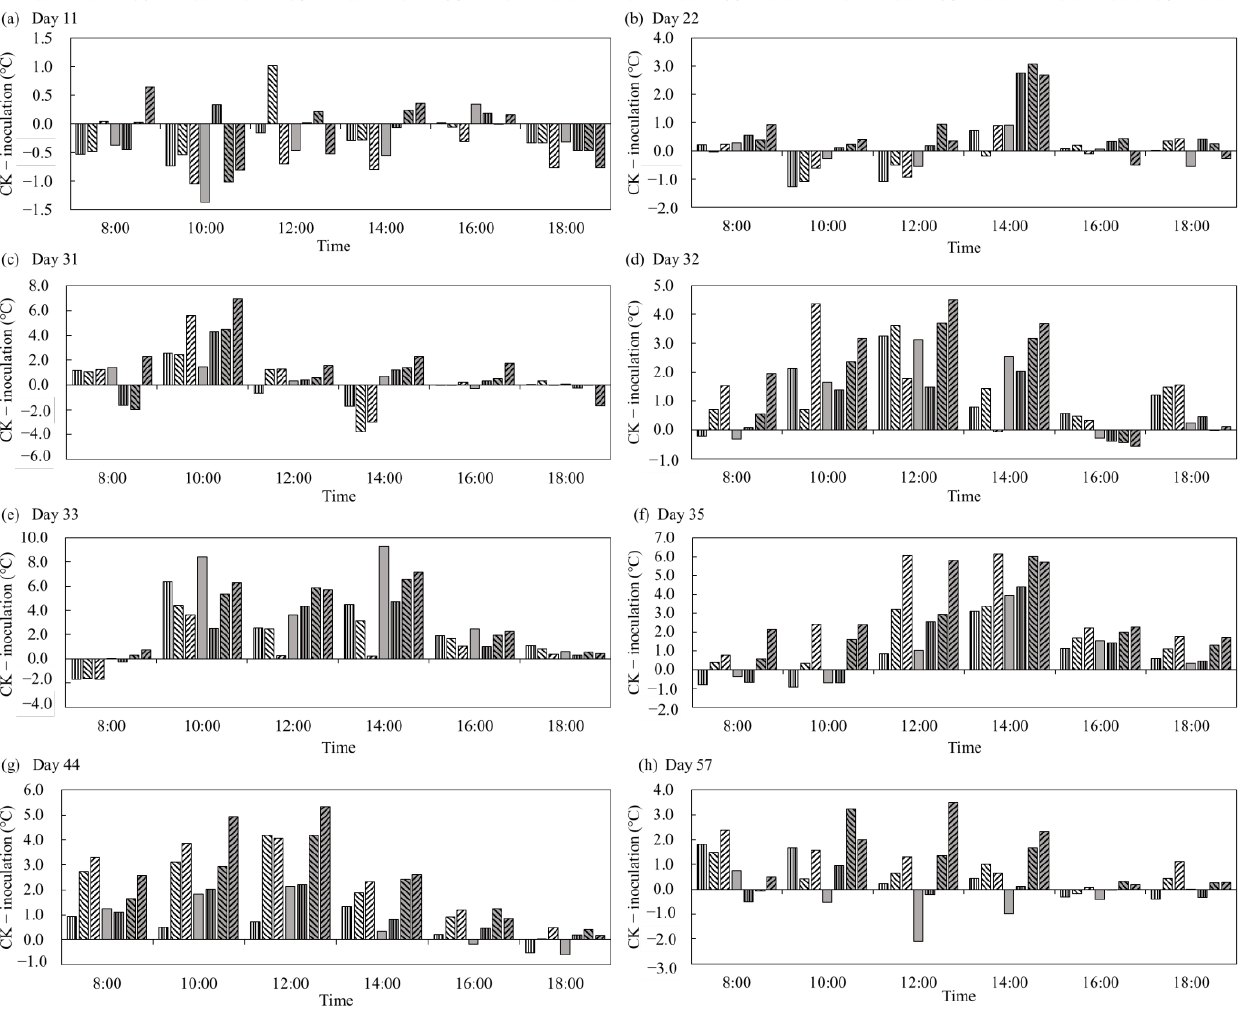
Figure 3. Differences in plant canopy temperature between controls and inoculation treatments on the ( a ) 11th, ( b ) 22nd, ( c ) 31st, ( d ) 32nd, ( e ) 33rd, ( f ) 35th, ( g ) 44th and ( h ) 57th days. CK—inoculation represents the difference between the mean of CK and inoculation. Control (CK), treatments with sterilized DSE and AMF; DSE20%, 2 × 10 5 CFU mL −1 of DSE with sterilized AMF; DSE40%, 4 × 10 5 CFU mL −1 of DSE with sterilized AMF; DSE80%, 8 × 10 5 CFU mL −1 of DSE with sterilized AMF; AMF, sterilized DSE with AMF; DSE20% + AMF → DSE80% + AMF, different concentration of DSE and AMF.